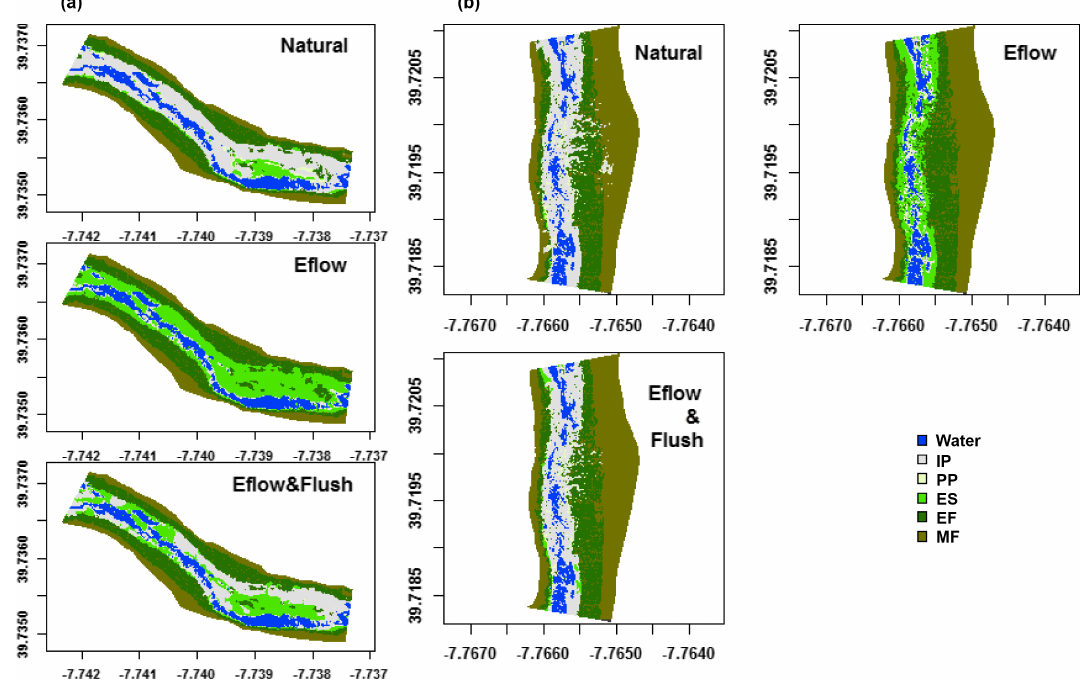
Figure 4. Expected patch mosaic of the riparian vegetation habitats shaped by the natural, Eflow, and Eflow&Flush flow regimes (detailed by succession phase, namely, initial phase – IP, pioneer phase – PP, early succession woodland phase – ES, established forest phase – EF, and mature forest phase – MF) in the OCBA study site (a) and in the OCPR study site (b)